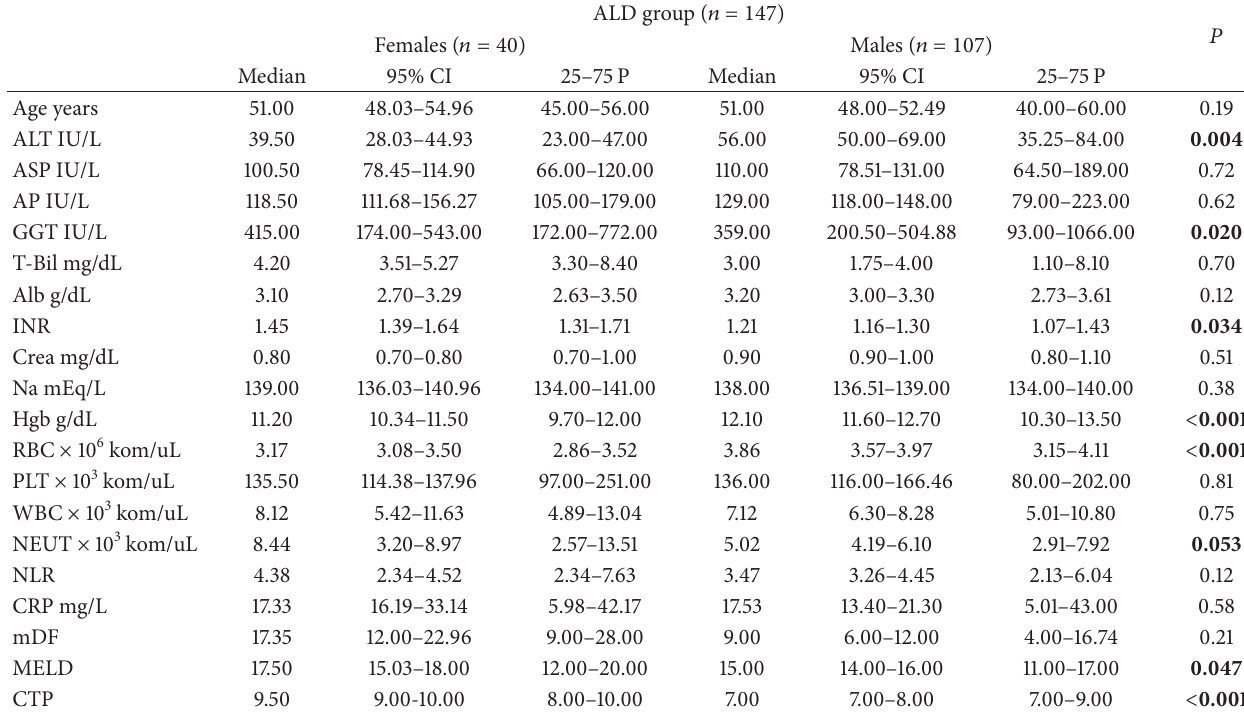
Table 2: Characteristics of patients with ALD based on their gender ∗ .